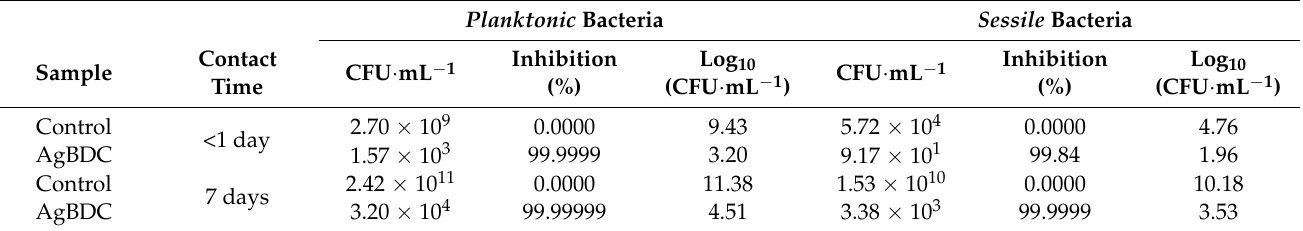
Table 2. Determination of planktonic and sessile E. coli bacterial viability by plate counting after 18 h (0.75 days in dark) or 7 days contact with the different proposed materials, expressed as CFU · mL − 1 , inhibition % (with respect to the control CFU · mL − 1 ) and Log 10 (CFU · mL − 1 ). Planktonic Bacteria Sessile Bacteria